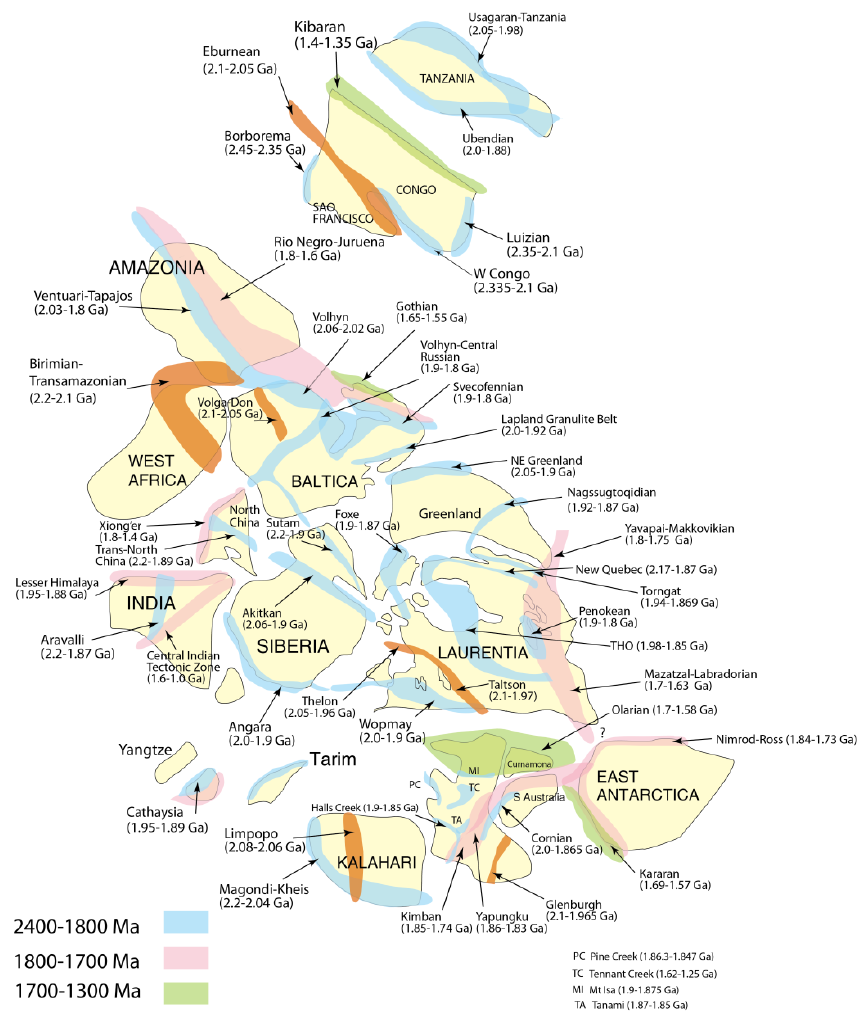
Figure 2. Diagrammatic assembly of Nuna showing major accretionary orogens (2400–1300 Ma). Reconstruction after Zhao et al. [16] and Evans and Mitchell